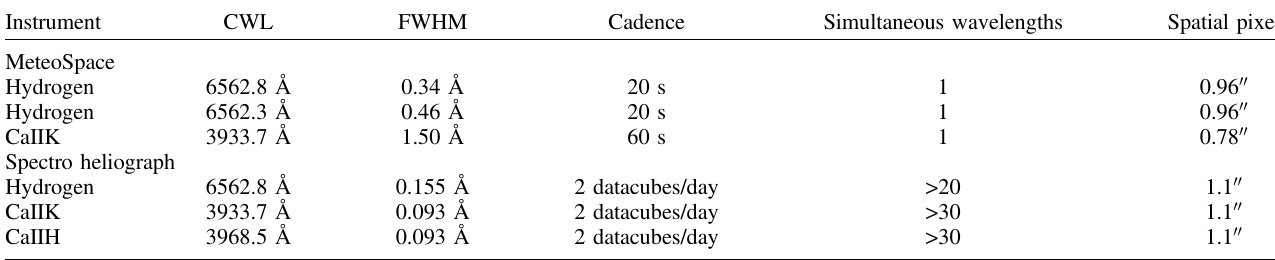
Table 1. Capabilities of the MeteoSpace and Spectroheliograph instruments.